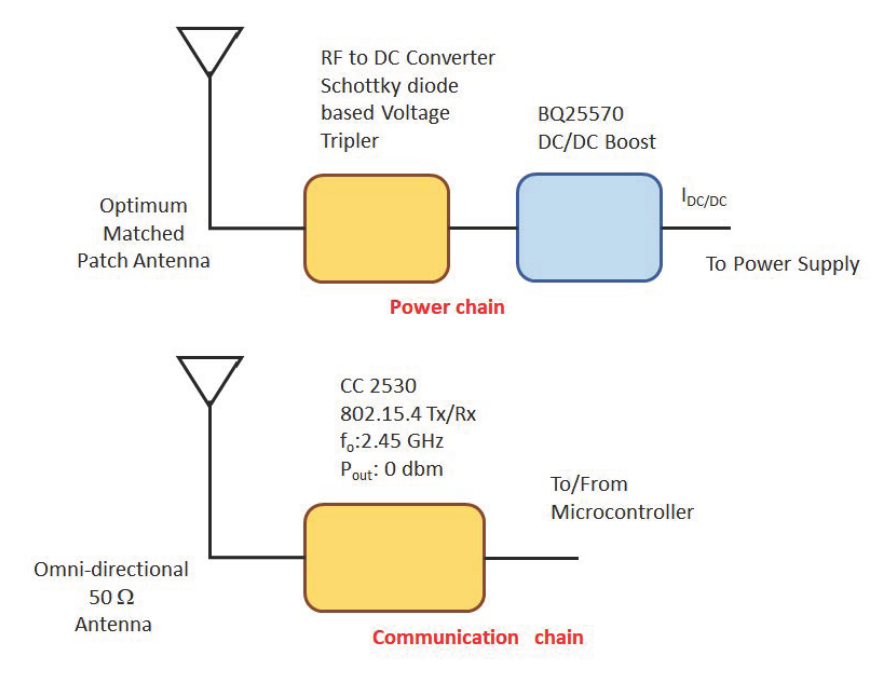
Figure 4. Rechargeable Node power and Tx/Rx